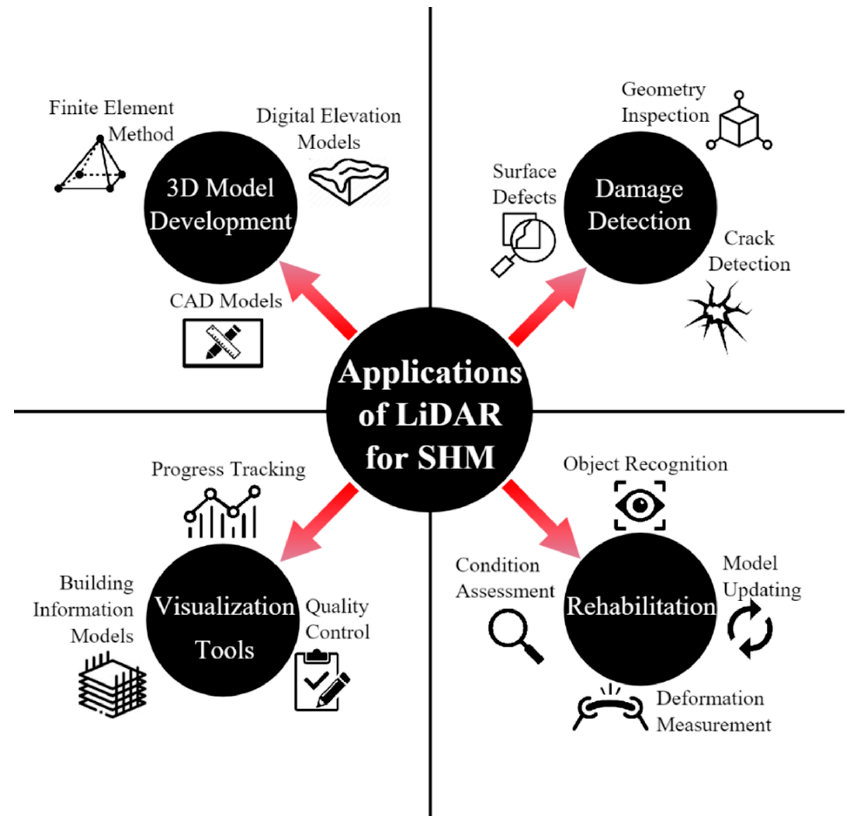
Figure 3. Applications of LiDAR for SHM.